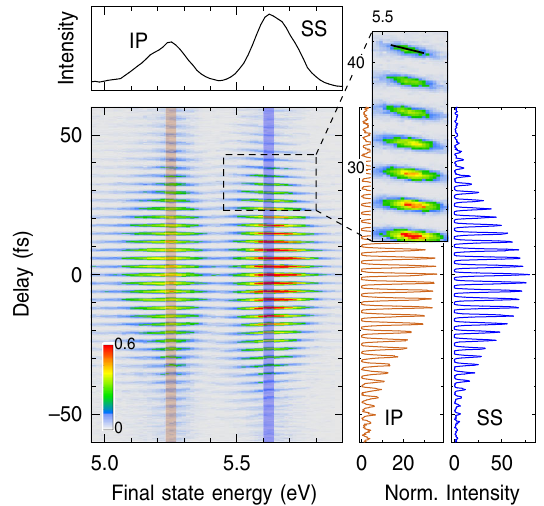
FIG. 6. ITR-4PP experiment on Ag(111) at a photon energy of ℏ ω ¼ 1 . 40 eV ( k ¼ 0 ). Left bottom: Color-coded photoelec- l k tron counts as a function of the pump-probe delay and final state energy; top: energy profile taken at t ¼ 0 fs. Right: I2PC cross sections at the IP and SS final state energies. The high signal-to- baseline ratios are expected for the high-order correlation experi- ment. Inset: The interference fringes of the SS state tilt towards t ¼ 0 fs with an increasing final state energy; the tilt angle is marked by the black line at approximately 42 fs.